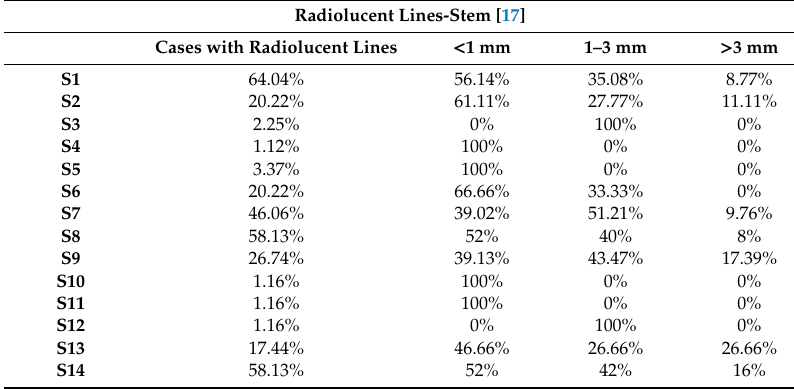
Table 2. Distribution of radiolucent lines of the